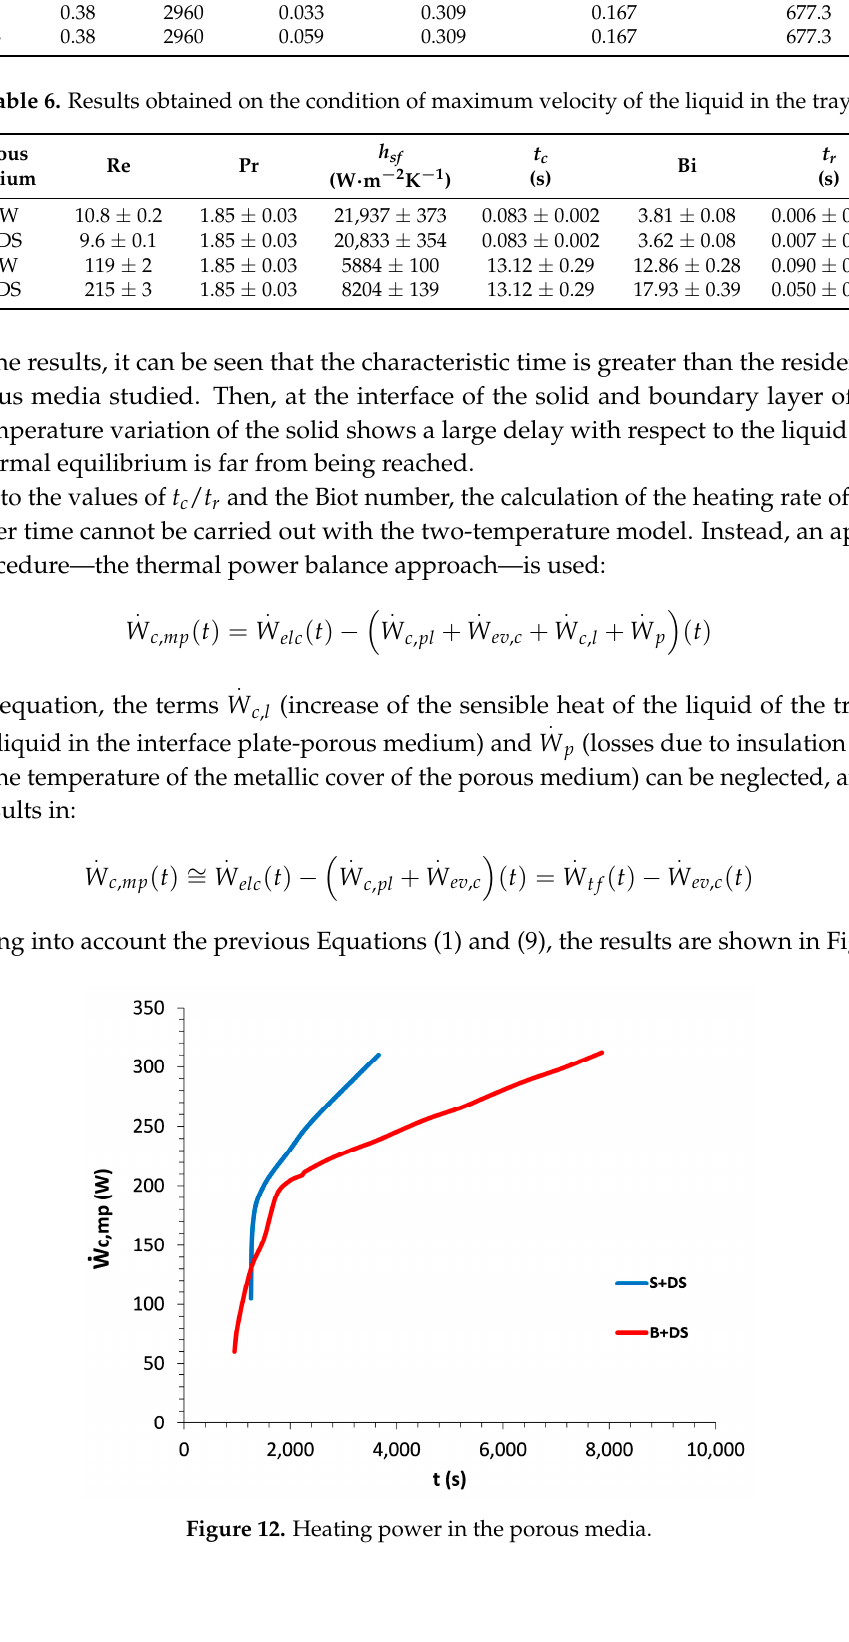
Table 5. Magnitude values.